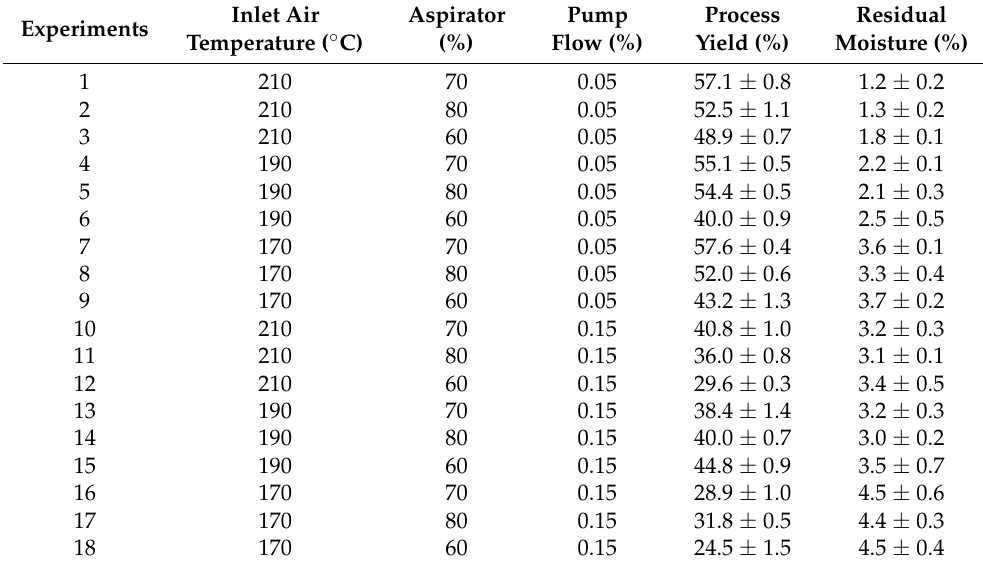
Table 1. Design matrix of the factorial experiment and results of the yield process and moisture content of the spray-dried